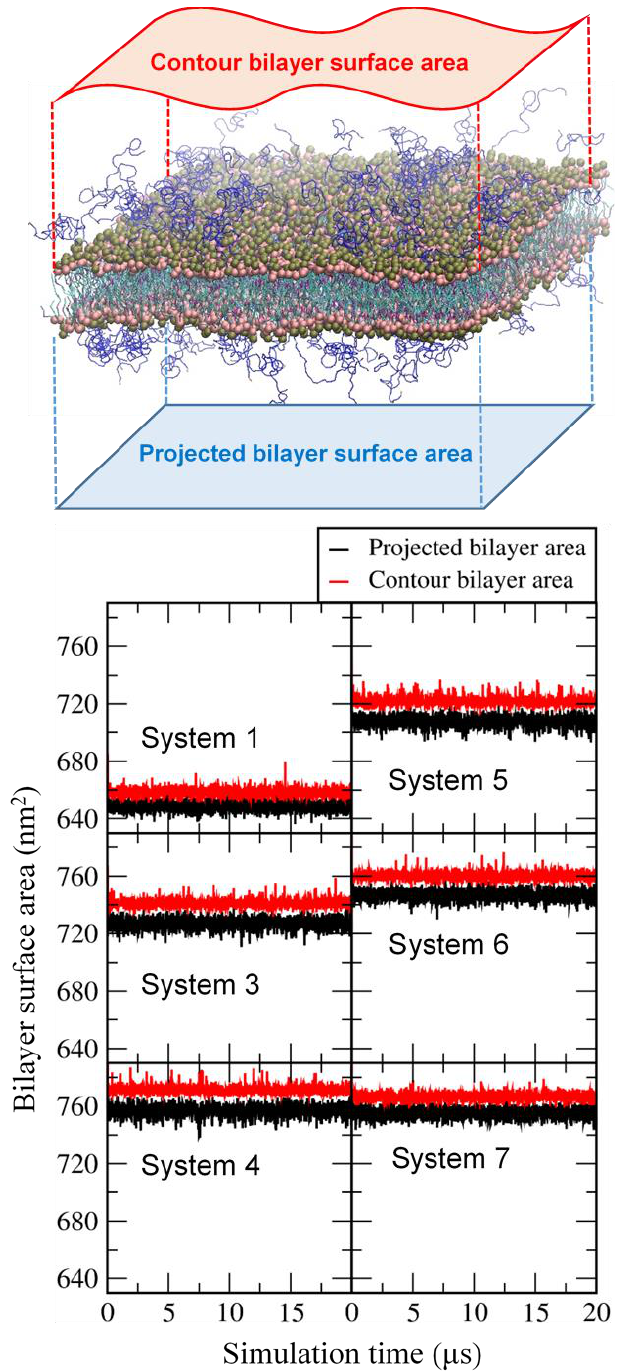
Figure 4. Projected and contour bilayer-surface areas as a function of simulation time.